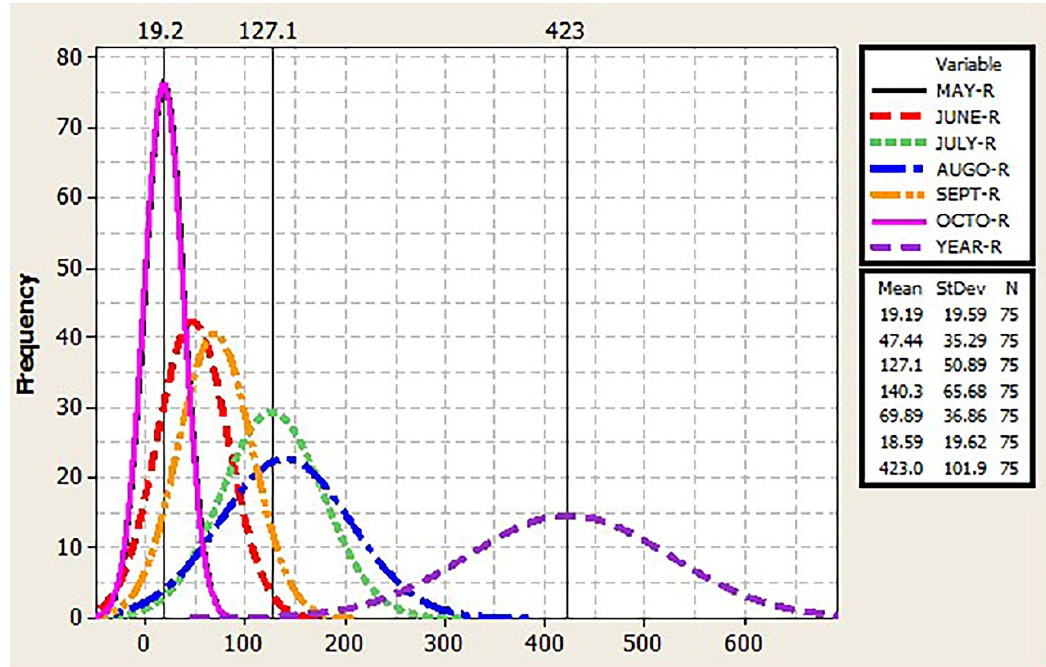
Figure 3. Seasonal (monthly and annual) precipitations frequency histogram.